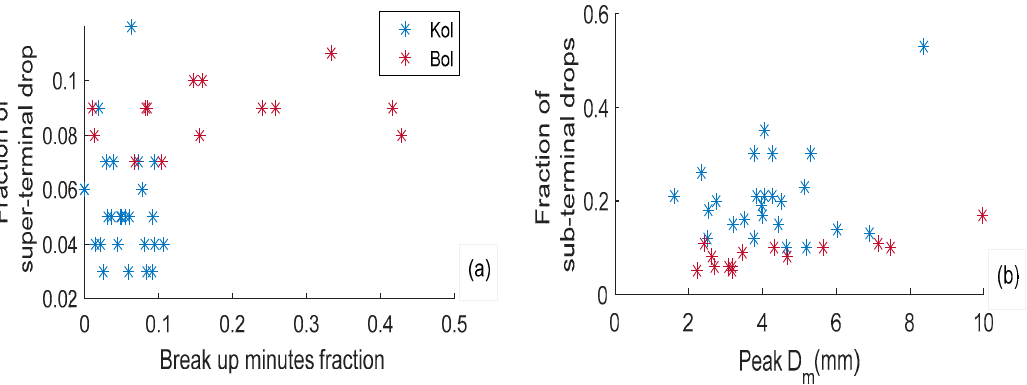
Figure 13. Relation between ( a ) the break-up minute fraction and fraction of super-terminal drops and ( b ) peak D m and fraction of sub-terminal drops in Kolkata and Bologna. The break-up minute fraction represents the ratio of the number of break-up minutes with the total rain minutes.